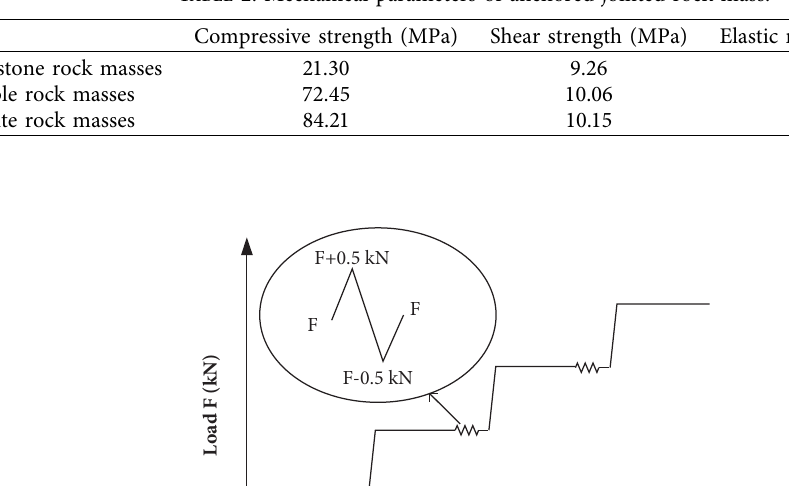
Table 2: Mechanical parameters of anchored jointed rock mass.